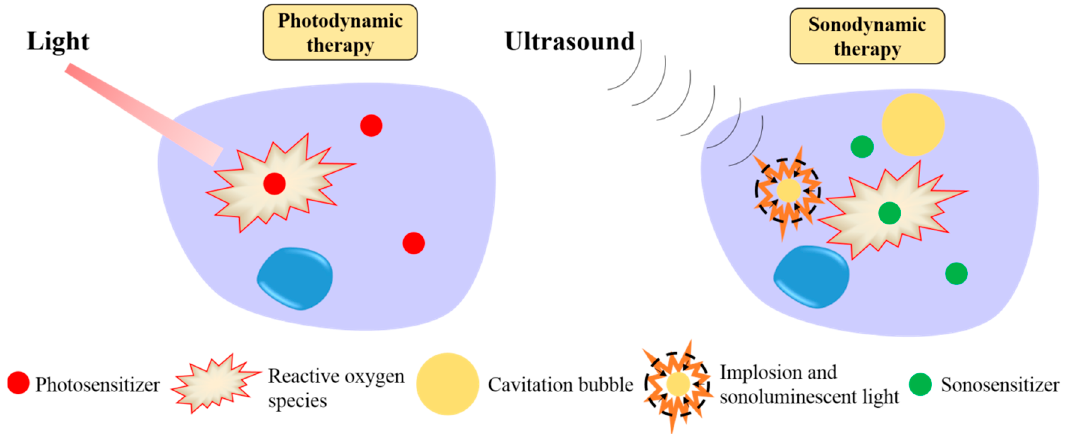
Scheme 1. Mechanisms of photodynamic therapy and sonodynamic therapy.